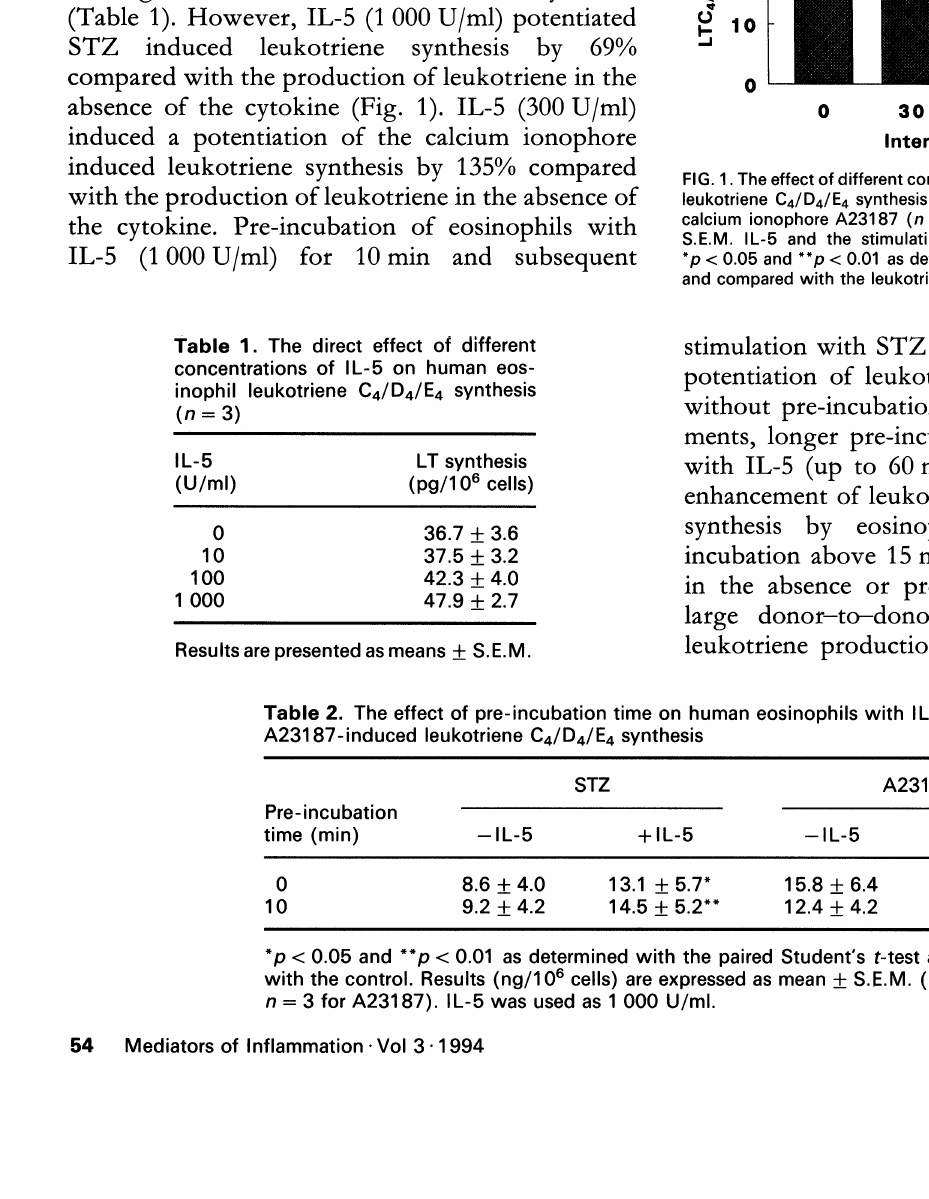
Table 2. The effect of pre-incubation time on human eosinophils with IL-5 on STZ- or A23187-induced leukotriene C4/D4/E4 synthesis STZ